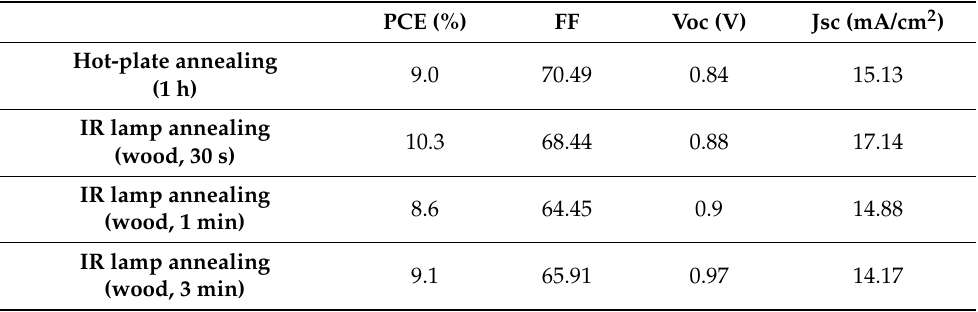
Table 1. Device parameters extracted from J–V characteristics of PVSCs with 1 wt% PAMAM